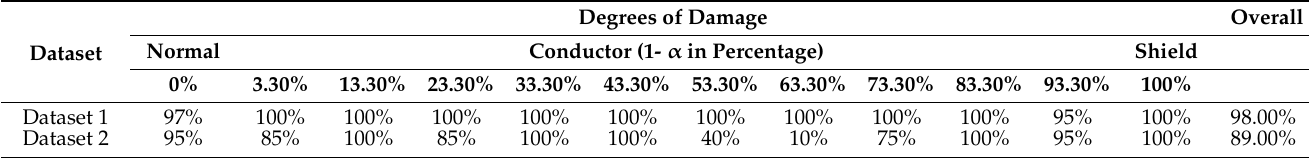
Table 4. Online fault detection accuracies of soft faults in the